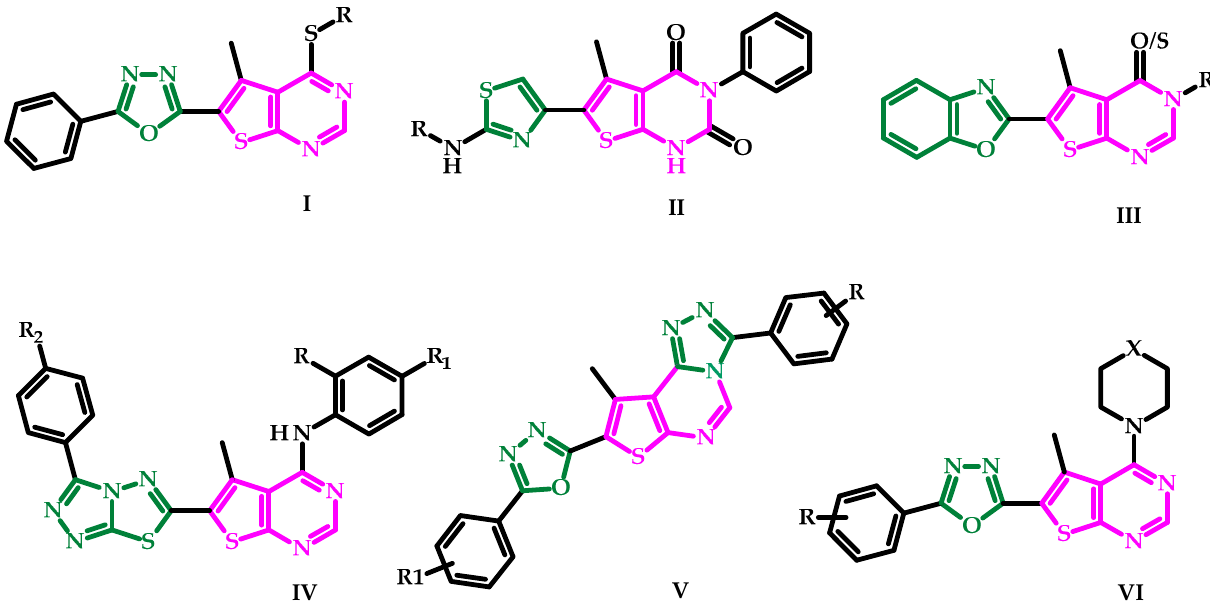
Figure 1. The derivatives of thieno[2,3- d ]pyrimidine with antibacterial properties. The successful application of the hybrid pharmacophore concept achieved by the com- bination of thieno[2,3- d ]pyrimidine with the other heterocycles has been reported by many other scientific groups. The modification of the position 6 of thieno[2,3- d ]pyrimidine with a triazolothiadiazole cycle allowed the obtaining of highly effective antibacterial agents IV , which were also active against P. aeruginosa [9]. The antimicrobial and antifungal properties were found to be typical for the compounds V modified with 1,3,4-oxadiazole [10]; their analogs bore morpholine or piperidine cycles at position 4 of the core heterocycle ( VI ) also showed antimicrobial properties [11]. Other reports have shown some examples of success- ful modifications of other positions of the thieno[2,3- d ]pyrimidine system as well as fusion of this ring system with different heterocycles (which led to the effective antimicrobials). The examples tetrahydrobenzo[4,5]thieno[2,3- d ]pyrimidine derivatives [12,13], 5-furyl [14] and 2-thienyl theinopyrimidines fused with triazole [15] or pyrimidine cycles can also be mentioned [16].